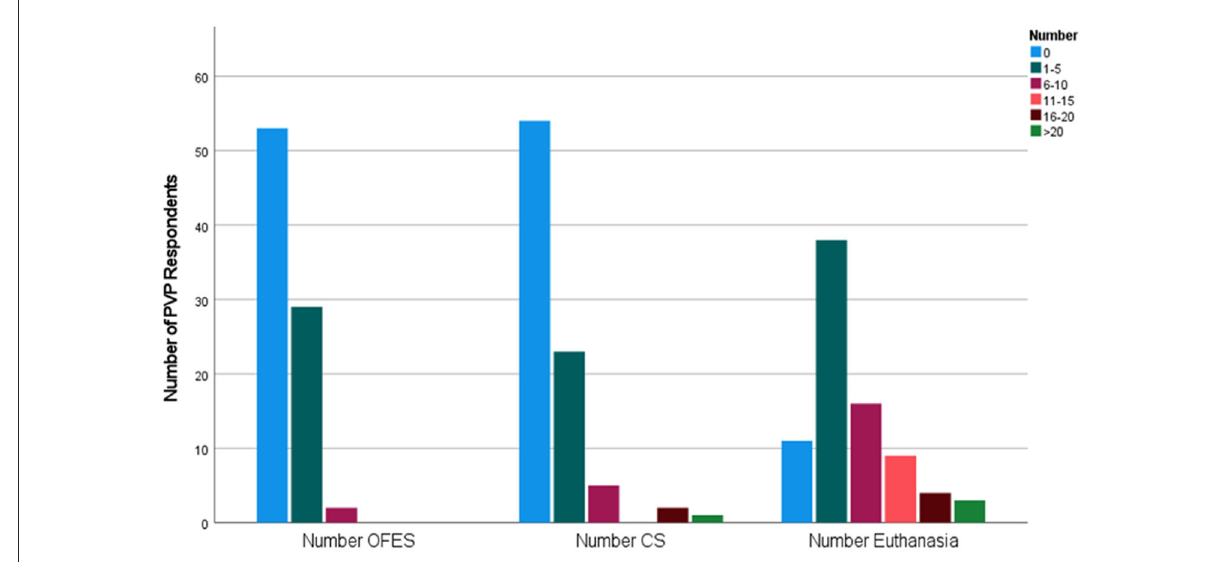
FIGURE1 The number of acutely injured cattle certified for on-farm emergency (OFES) slaughter and casualty slaughter (CS) or euthanised reported by Private Veterinary Practitioners ( n = 85) in 2020.